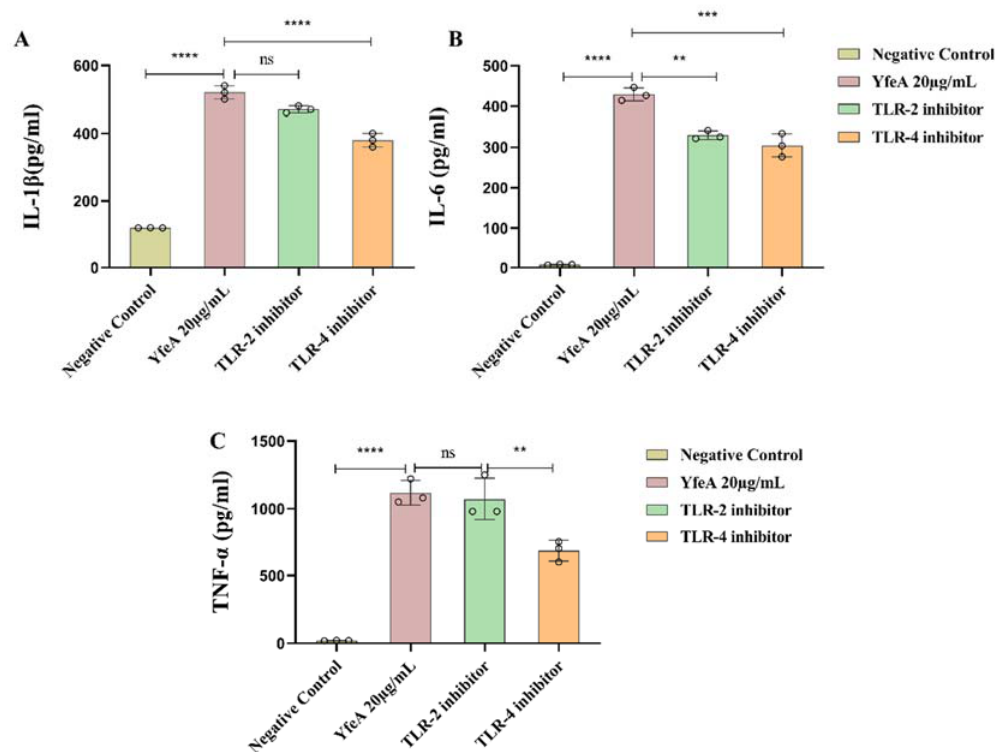
Figure 6. Analysis of the recognition receptor of YfeA. RAW 264.7 cells were plated into 6 ‐ well plates at a density of 2 × 10 6 cells/well overnight, then anti ‐ TLR2 and anti ‐ TLR4 monoclonal antibodies were used to block their corresponding toll ‐ like receptor. Both antibodies were added to a final concentration of 10 μ g/mL for 2 h separately before YfeA stimulation. Secretion levels of ( A ) IL ‐ 1 β , ( B ) IL ‐ 6, and ( C ) TNF ‐α in the culture supernatants were detected after 12 h incubation. Significant differences between groups are indicated by ** p < 0.01, *** p < 0.001, and **** p < 0.0001, ns p < 0.05.